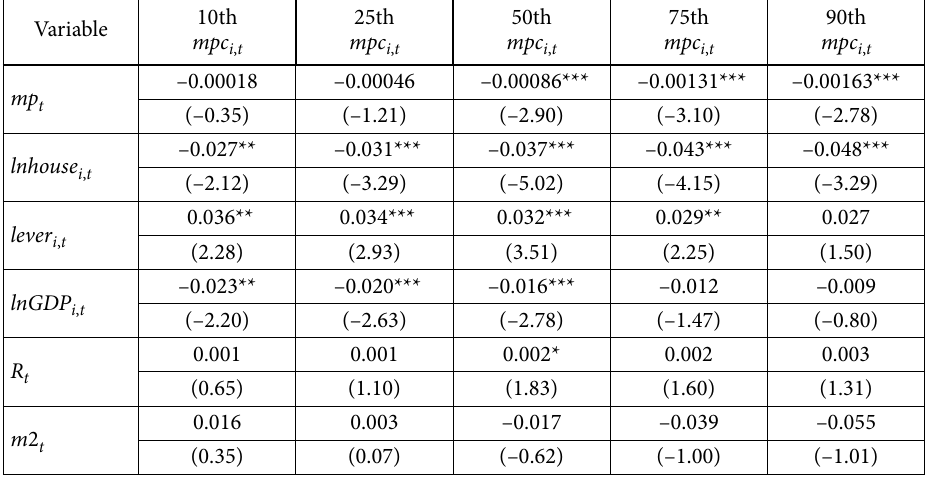
Table 11. Effects of different income macroprudential policies